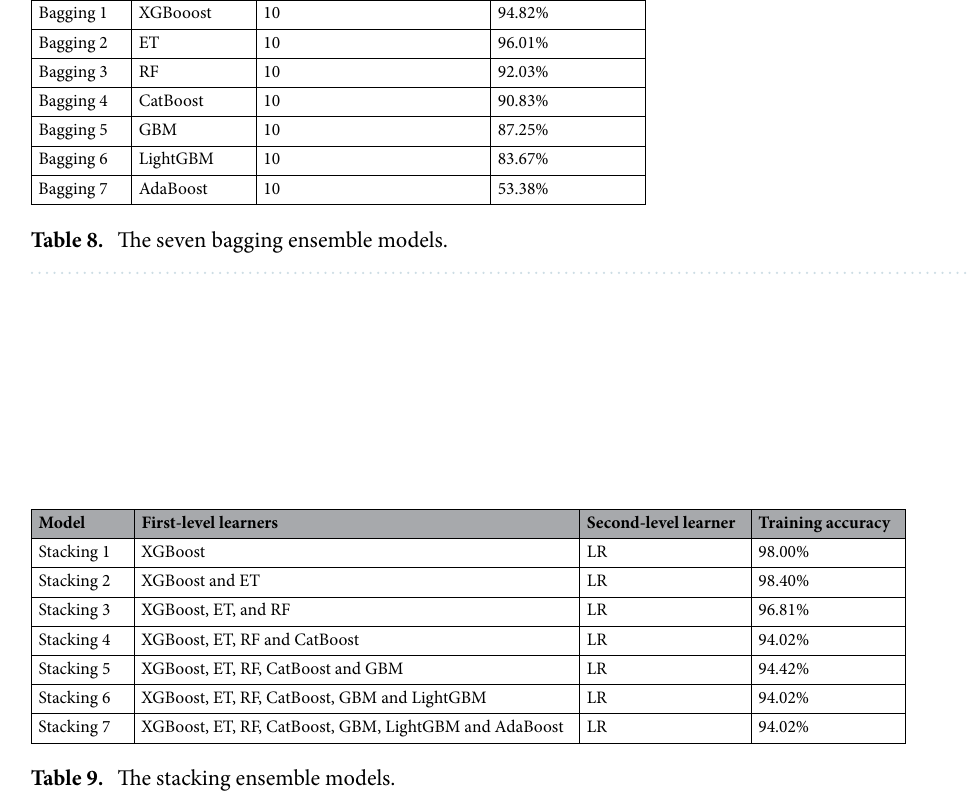
Table 9. The stacking ensemble